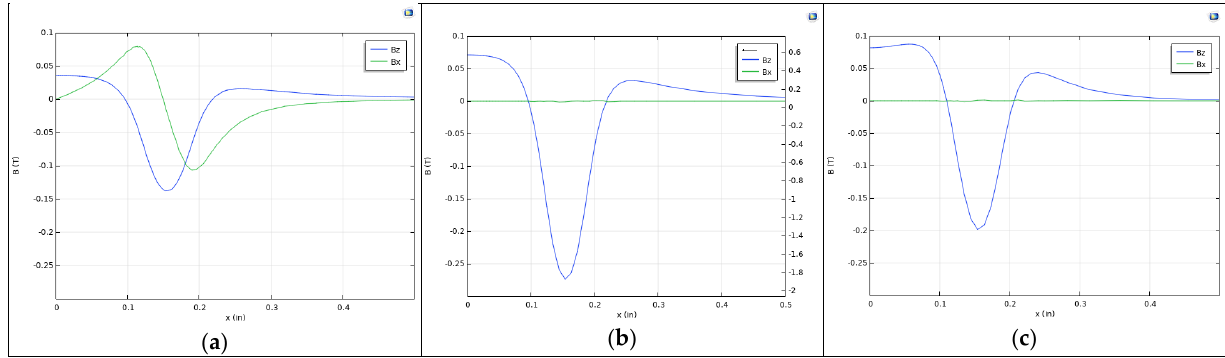
Figure 5. Simulated transverse B z and B x on z = 0 plane for: ( a ) single; ( b ) inner pair only; and ( c ) full stack (no space between inner and outer pairs).